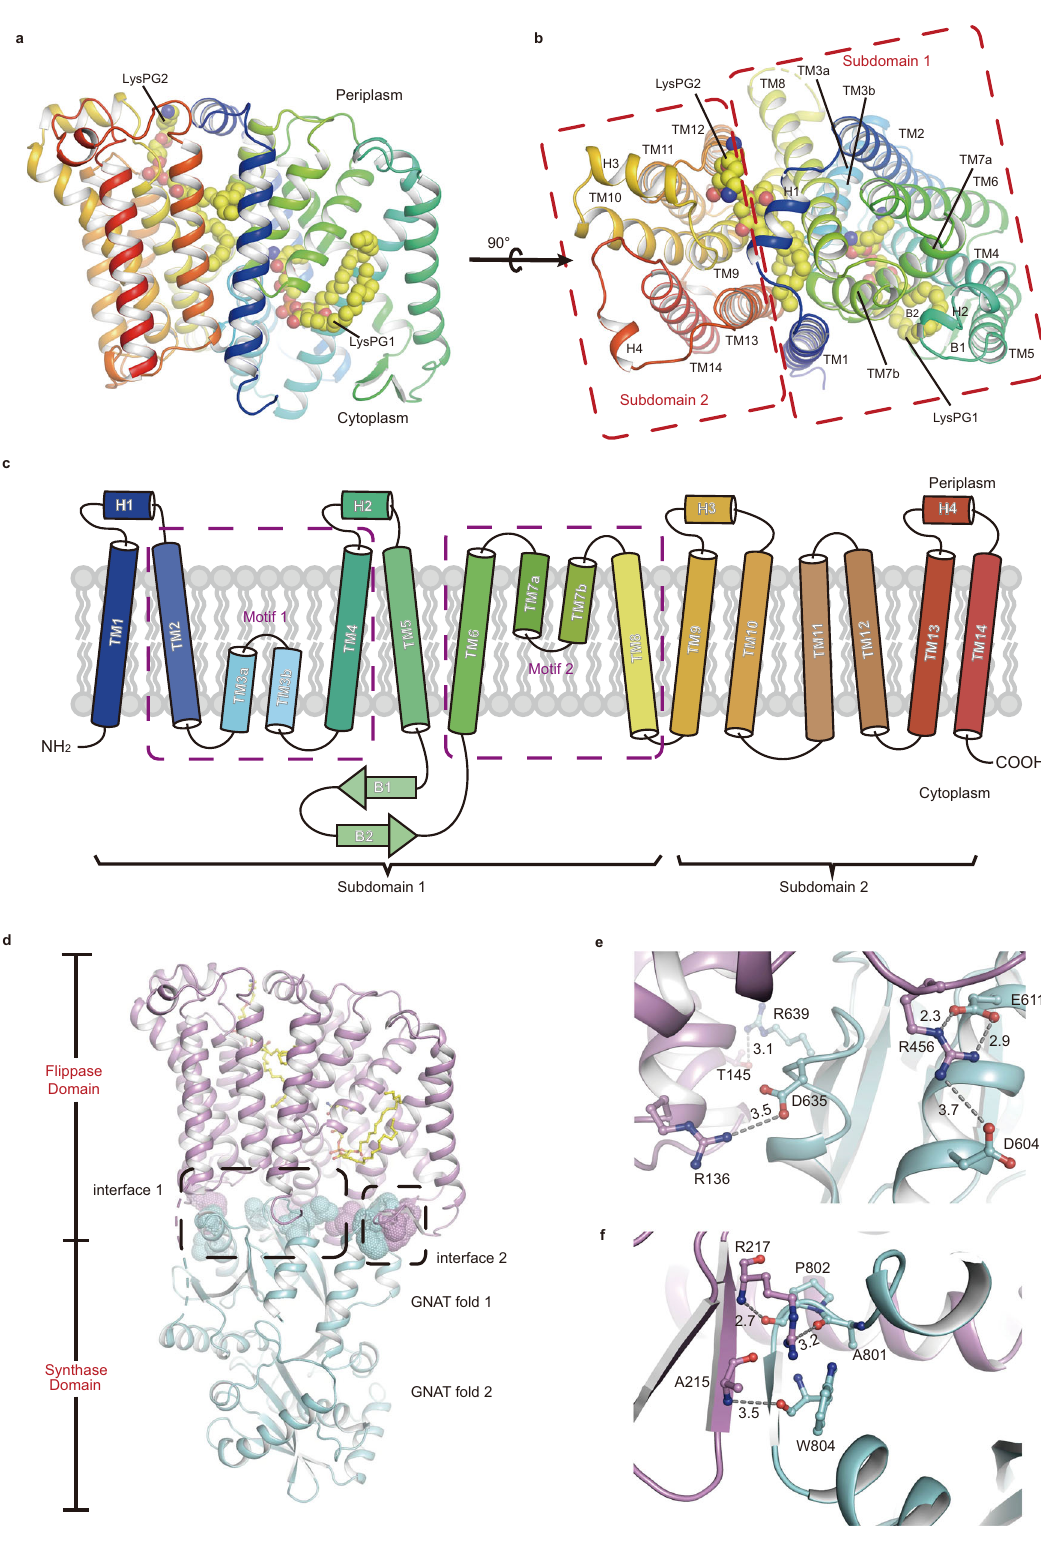
tandem repeats of the General Control Nonderepressible 5 (a histone acetyltransferase of a transcriptional regulatory complex) (Supplementary Fig. 4). The GNAT fold 1 of the synthase